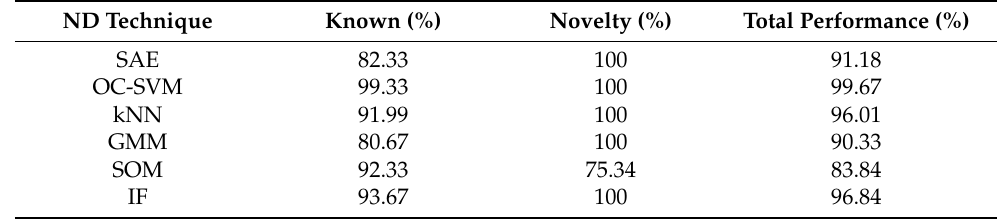
Table 14. Numerical results of the novelty detection obtained for the fifth case study of the